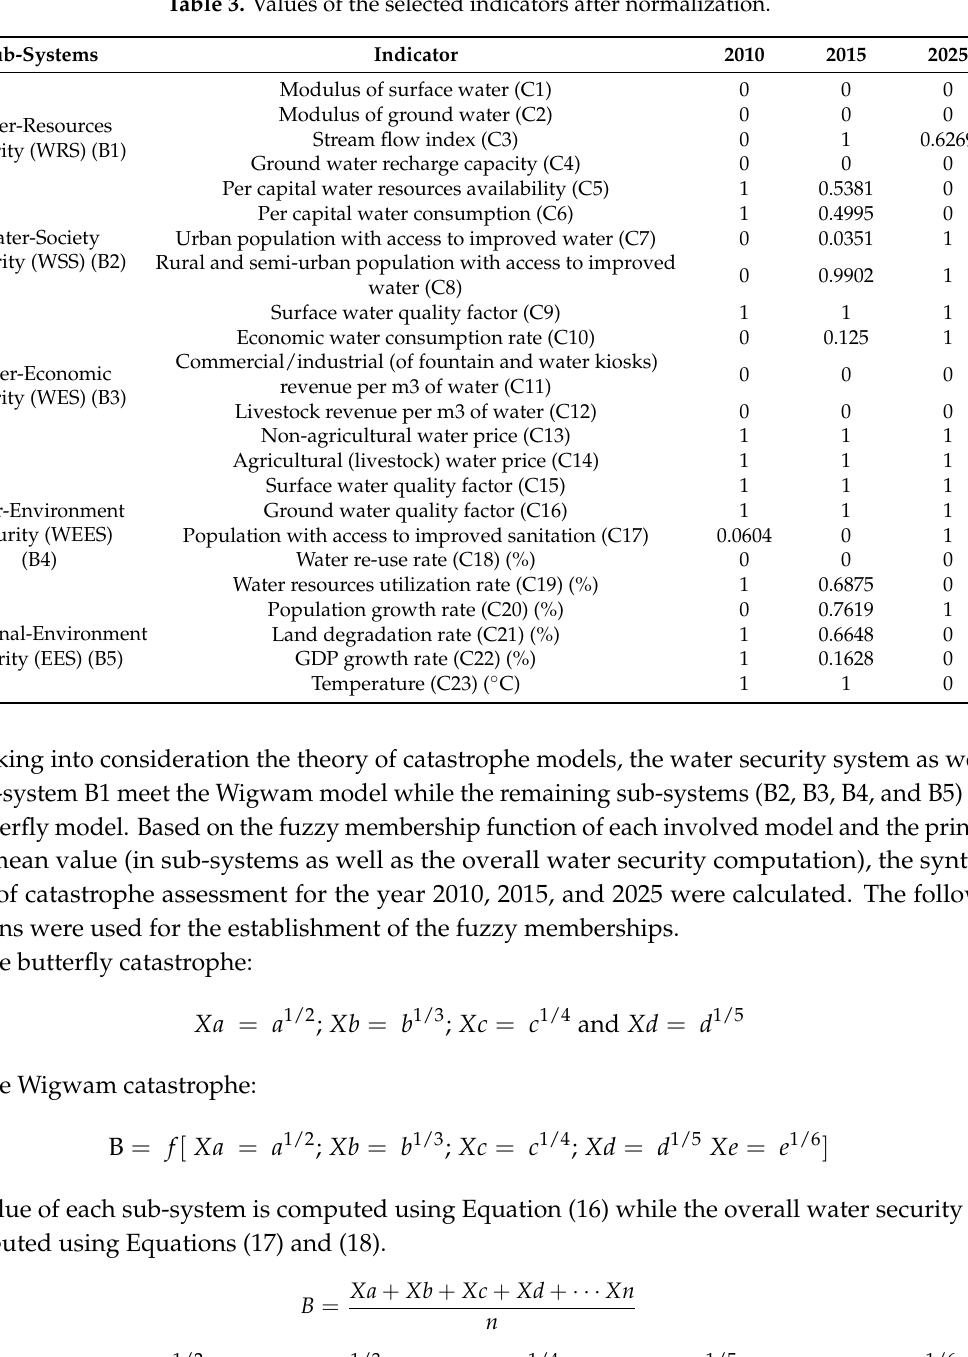
Table 3. Values of the selected indicators after